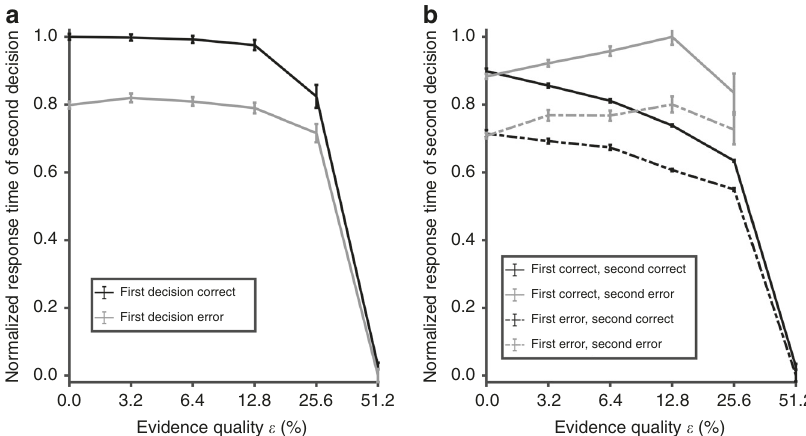
Fig. 3 Model accounts for and predicts subsequent response times. a Normalized response times of the second decision when the fi rst decision is correct (black) and error (grey). The model exhibits faster response times, when the fi rst decision is error compared to correct replicating experimental observations 43 . b Response times of the second decisions are further split into error (grey) and correct (black) decisions. Model predicts a slightly bigger difference between second error responses (bold vs. dashed grey lines) than second correct responses (bold vs. dashed black lines). Error bars are s.e.m.